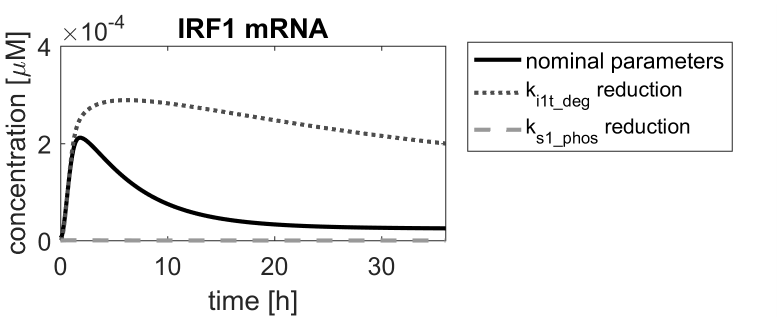
Figure 9. Comparison of IRF1 mRNA responses in the model with nominal parameters (solid black line) and parameters reduced by a factor of α = 0.15 (gray dashed and dotted